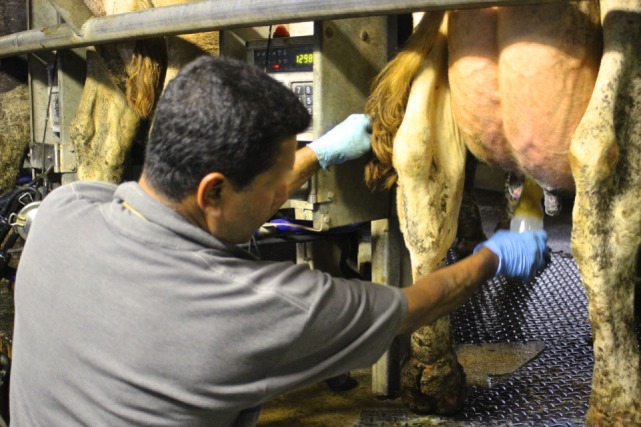
An Italian dairy worker pre-dipping teat in a rotary parlor.